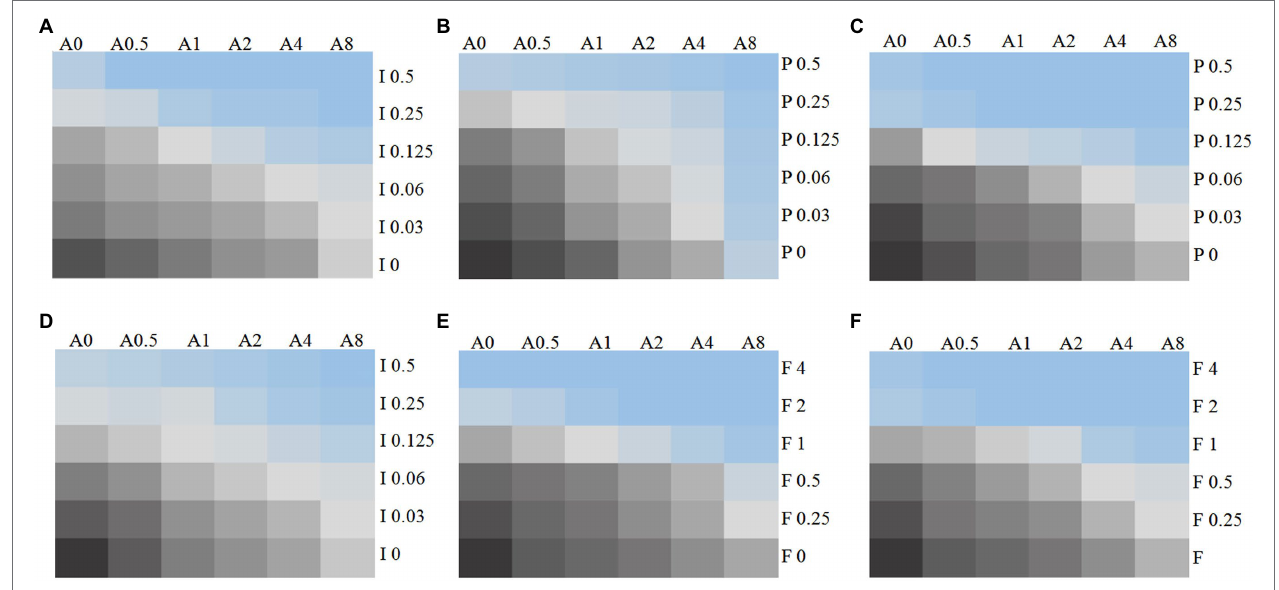
FIGURE 1 | Chromatic scale diagram of synergistic effects of partial drug sensitivity results. Several drug sensitivity diagrams with obvious synergistic effect are listed in accordance with the in vitro drug sensitivity test and checkerboard method, (A) C. auris AR 382 17-AAG + ITR; (B) C. auris AR 382 17-AAG + POS; (C) 5,150 17-AAG + POS; (D) R9 ITR; (E) R2 FLU; and (F) 5,150 FLU. From black to blue, indicating that the fungus growth gradually decreased, A represents 17- AAG, I represents ITR, V represents VOR, P represents POS, and the number after the letter represents concentration ( μ